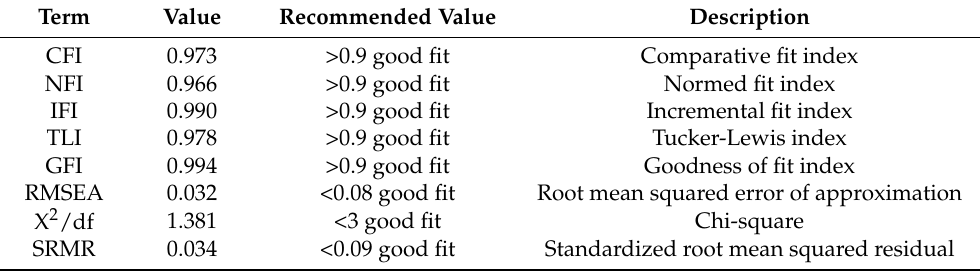
Table 7. Goodness-of-fit indices results.